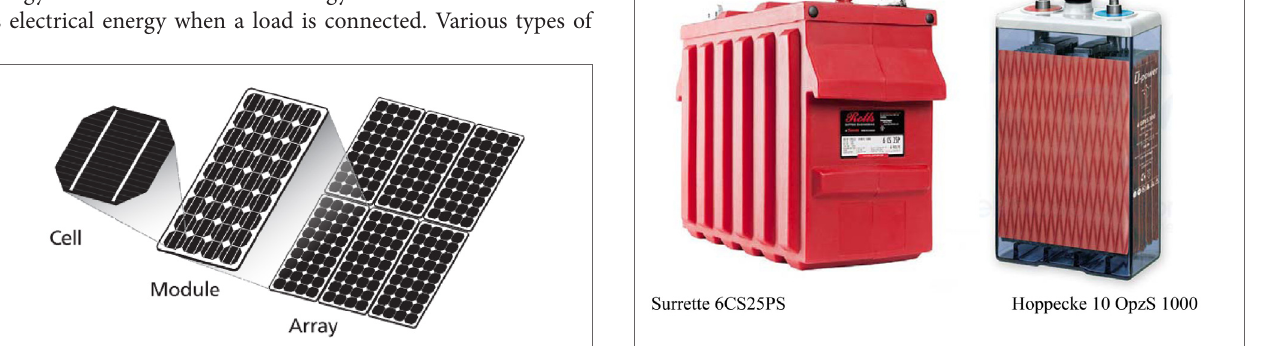
FigUre 5 | PV cell, module, and array (samlex solar, 2015) .